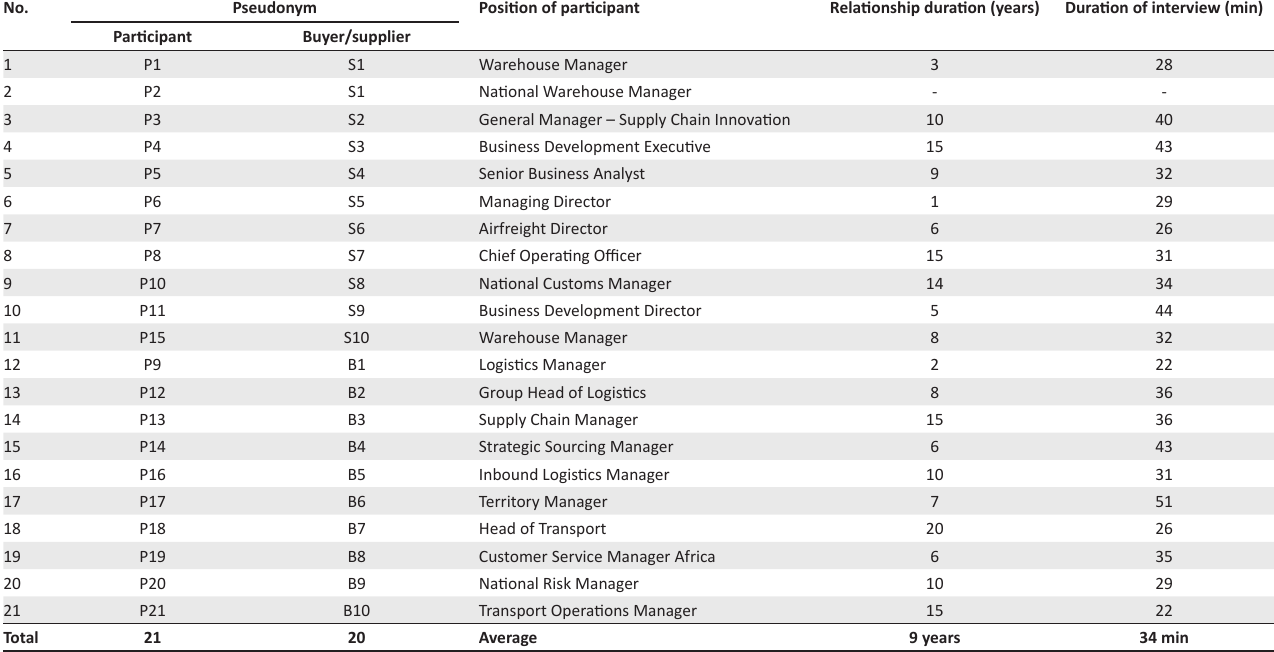
TABLE 1: Participants’